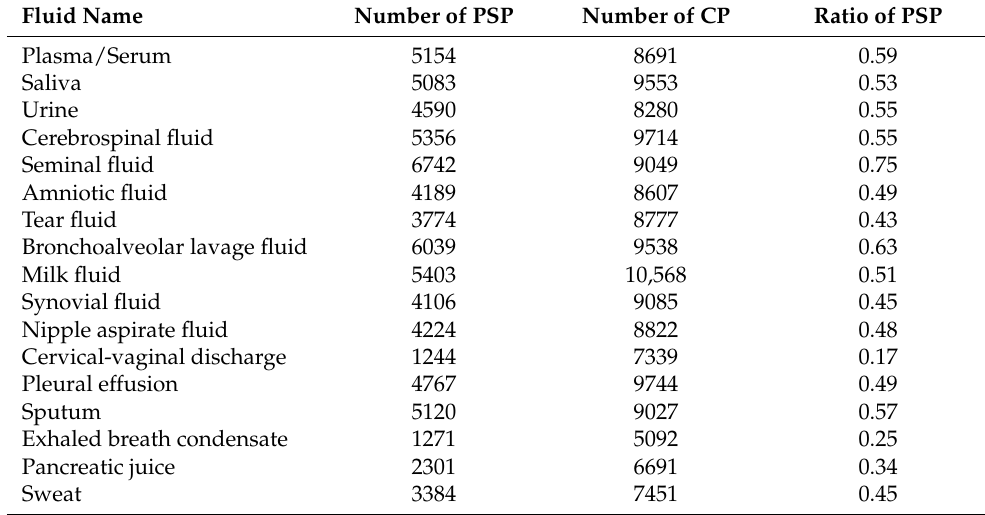
Table 5. The numbers and proportions of potentially secreted proteins in 17 human body fluids.